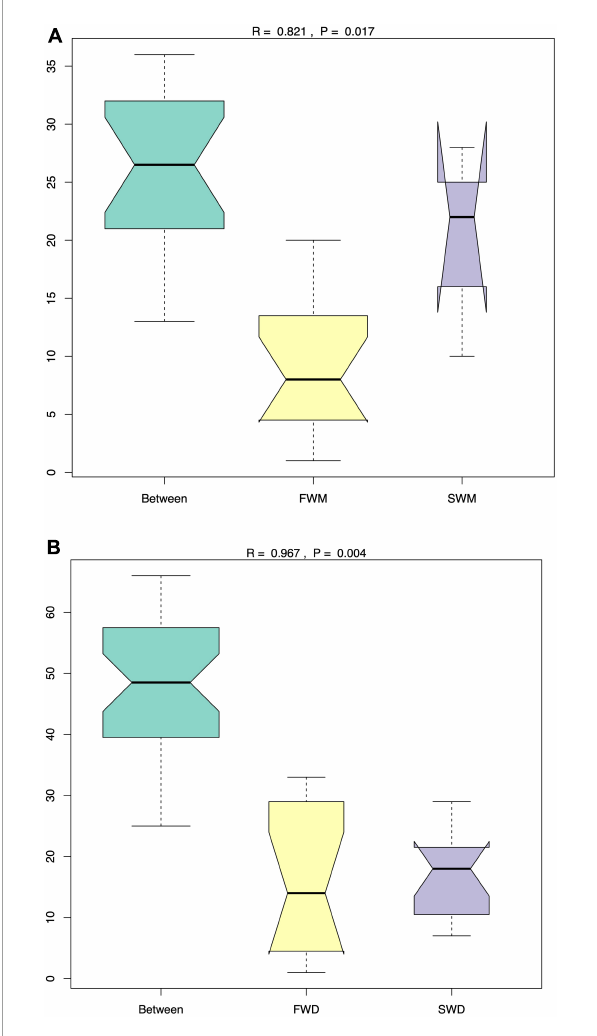
FIGURE2 The ANOSIM analysis revealed that the (A) mucosa-associated microbiota and (B) digesta-associated microbiota were significantly different between FW and SW Asian sea bass. FWD, freshwater digesta samples; SWD, seawater digesta samples; FWM, freshwater mucosa samples; SWM, seawater mucosa samples.